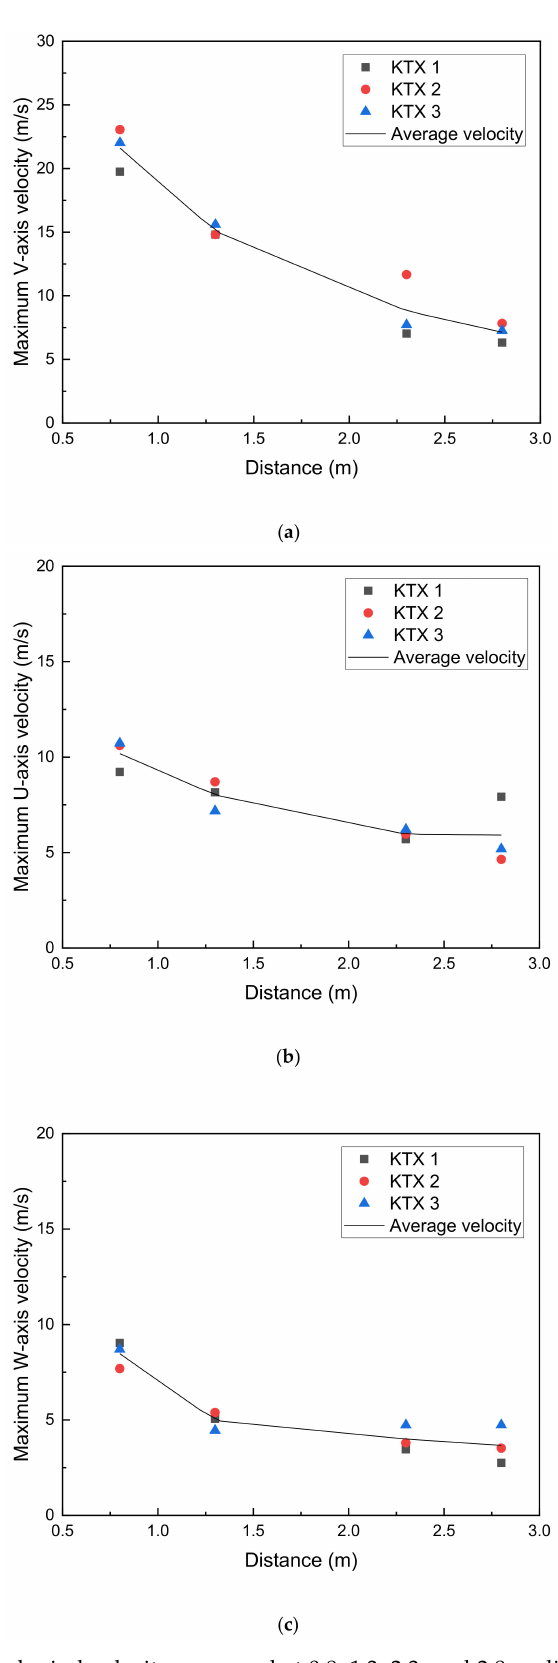
Figure 7. Train-induced wind velocity measured at 0.8, 1.3, 2.3, and 2.8 m distances from the train surface in each direction. ( a ) Train travel direction; ( b ) train width direction; ( c ) height